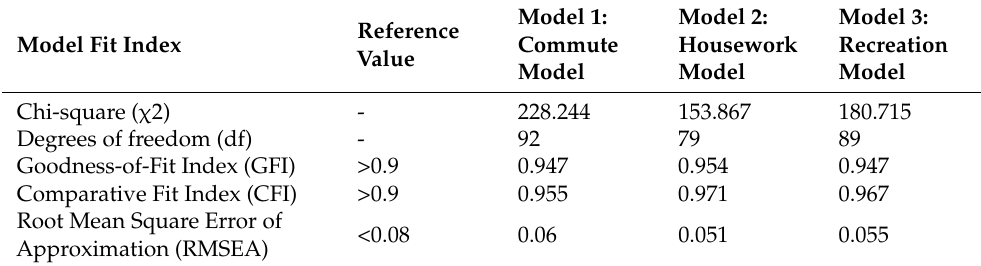
Table 6. The model fit indices for the SEM.